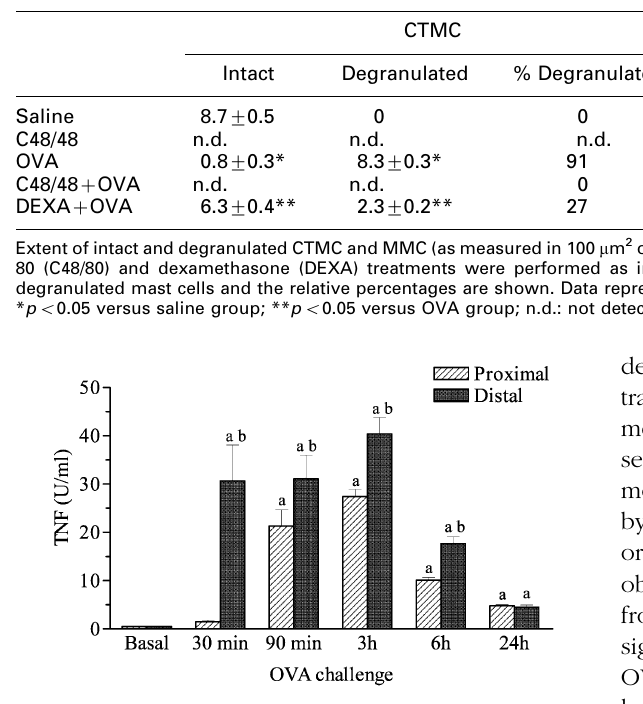
FIG. 2. Temporal profile of TNF- a activity in supernatants from proximal and distal tracheal segments after OVA challenge. Segments obtained from 14-day sensitized rats were isolated and placed in 24-well plates containing RMPI 1640 culture medium. OVA challenge was performed after 60 min, allowing for equilibrium. After the indicated time intervals, samples (100 m l) were recovered for TNF- a deter- mination by the L-929 bioassay. The data represent mean 9 / standard error of the mean from nine to 13 experiments. a, p B / 0.05 in comparison with basal levels; b, p B / 0.05 in comparison with the proximal segments.